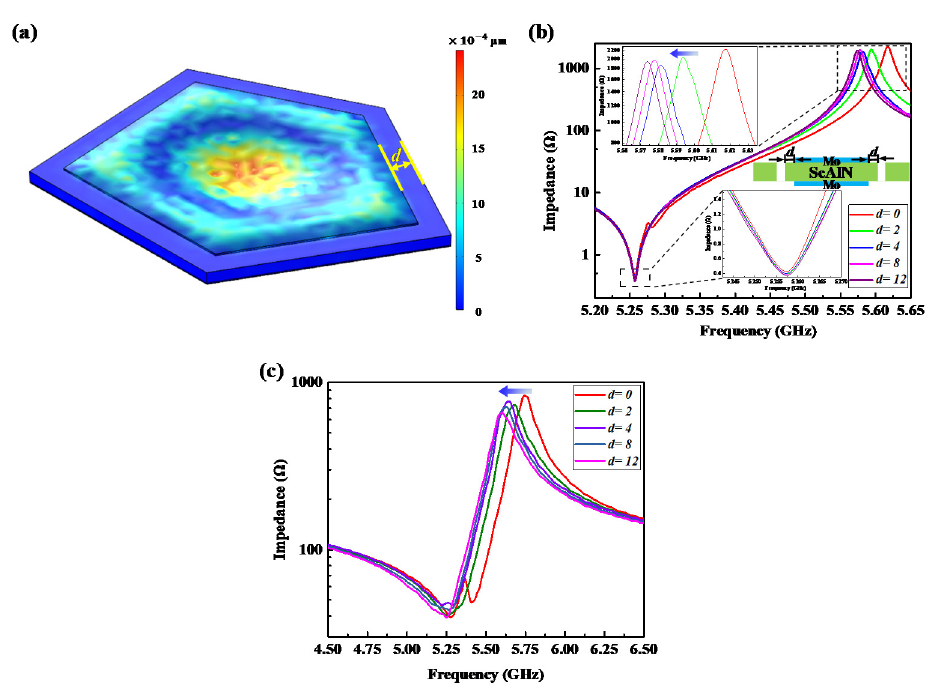
Figure 4. ( a ) The displacement shape at resonant frequency. Impedance curves of FBARs with the distance d changed: ( b ) Simulated results. ( c ) Measured results.